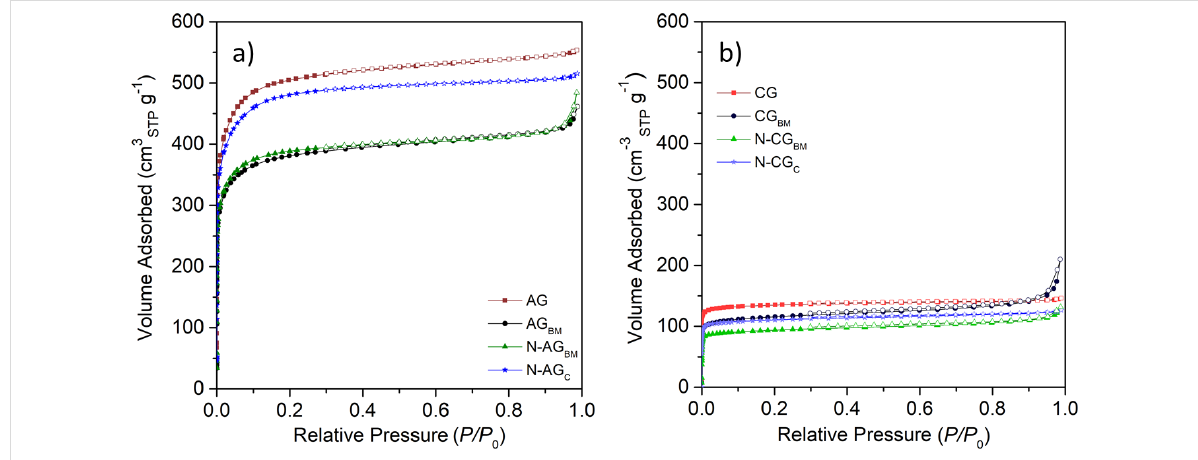
Figure 6: N 2 adsorption/desorption isotherms at − 196 °C for activated carbons (a) and carbonized carbons (b).